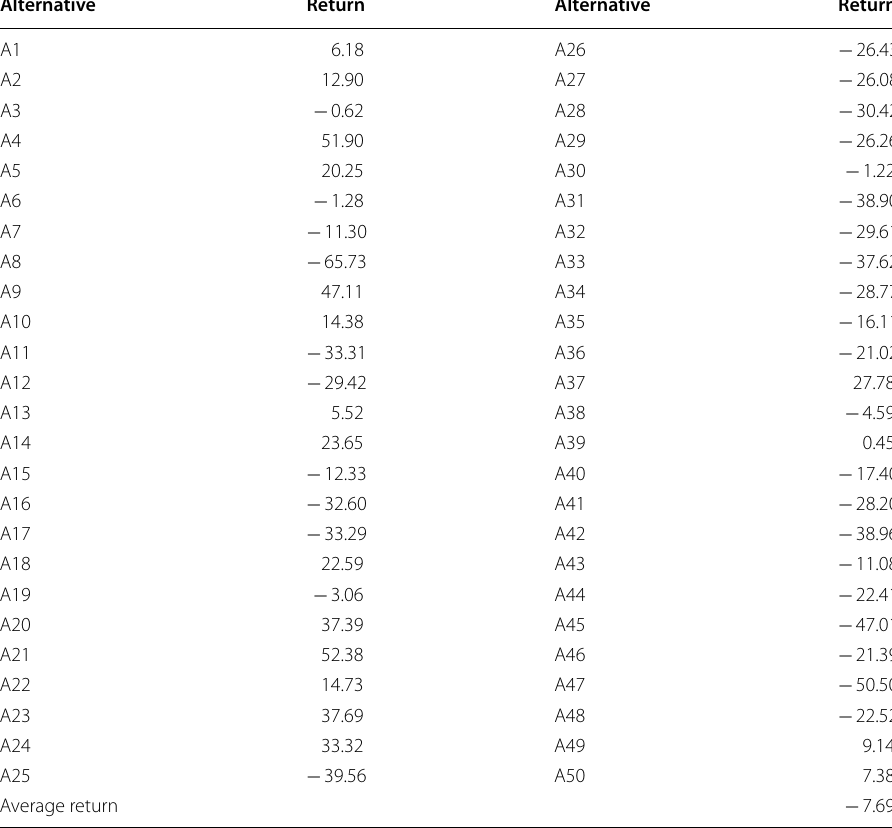
Table 9 Real return in the next period Alternative